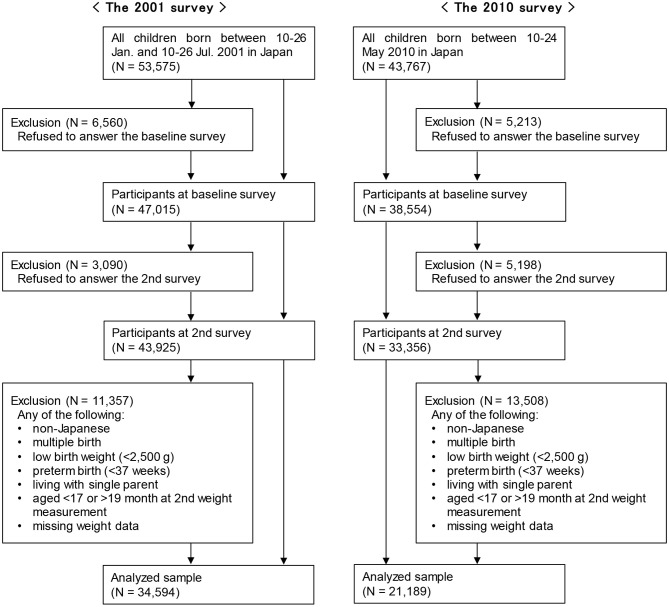
Study population.